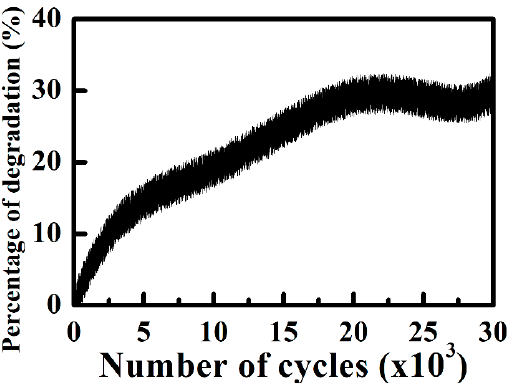
Figure 16. The percentage of degradation of ASSECD undergoing repeated coloring and bleaching for 3 × 10 4 cycles.